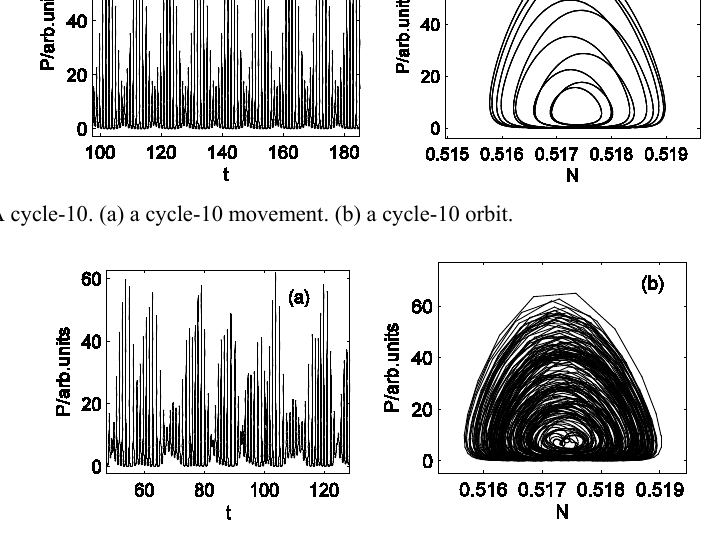
Fig. 4. Chaos. (a) a chaotic movement. (b) a chaotic attractor. When f 1 =0.04kHz, the laser is motivated to lead to a different beating state shown